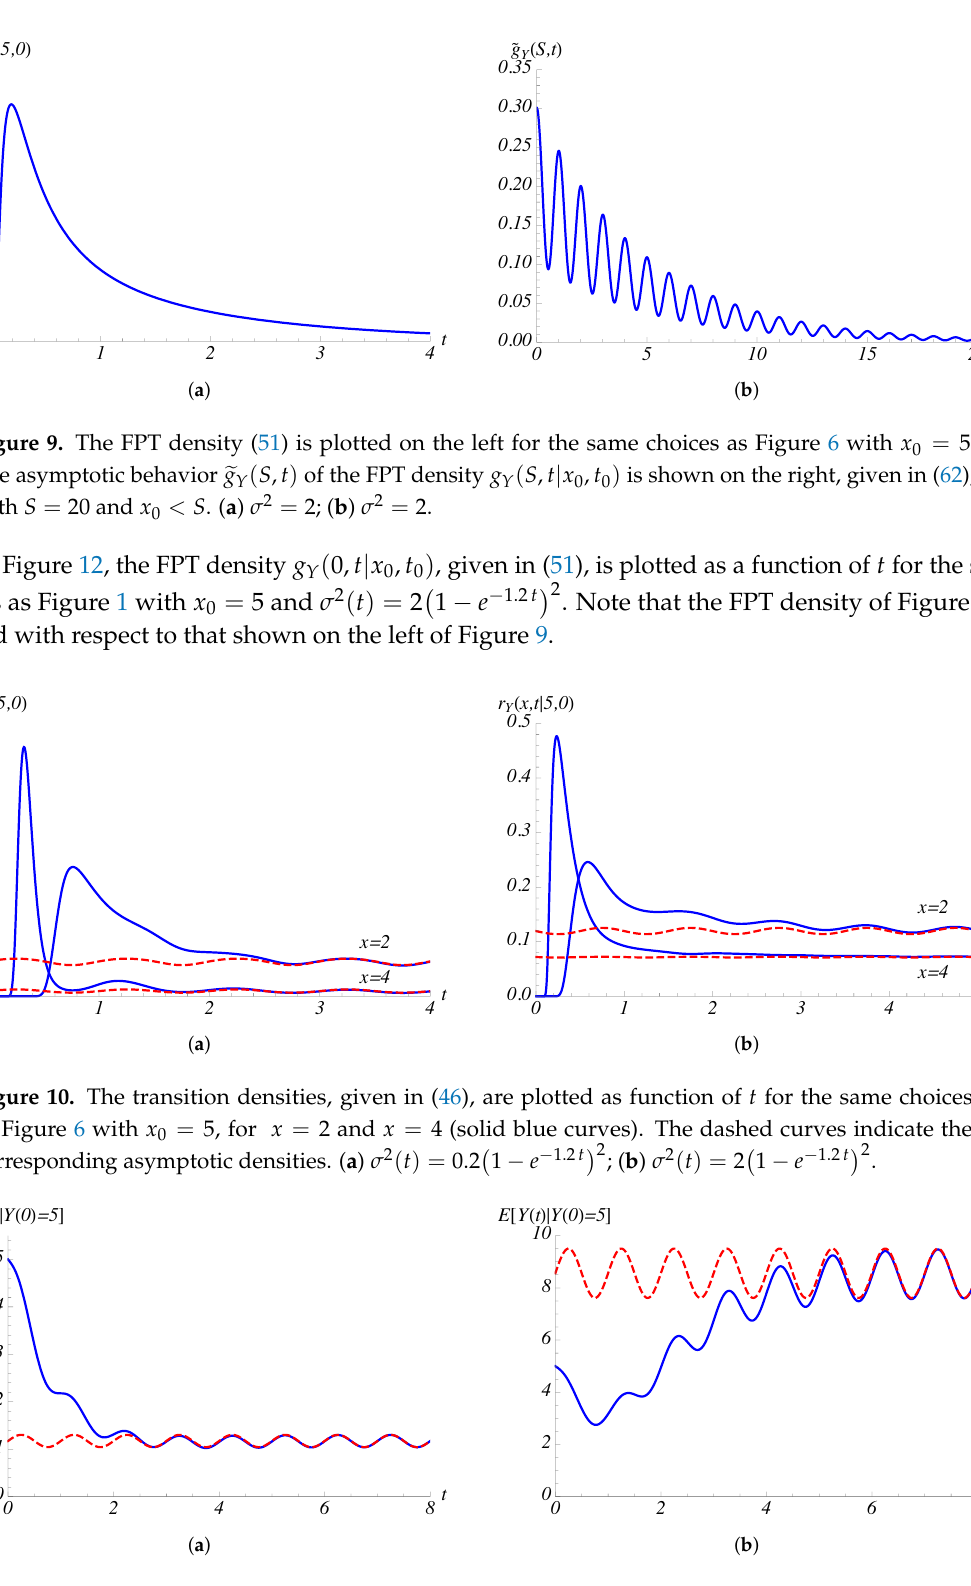
(cid:0) (cid:1) 2 1 − e − 1.2 t ; ( b ) σ 2 ( t ) =